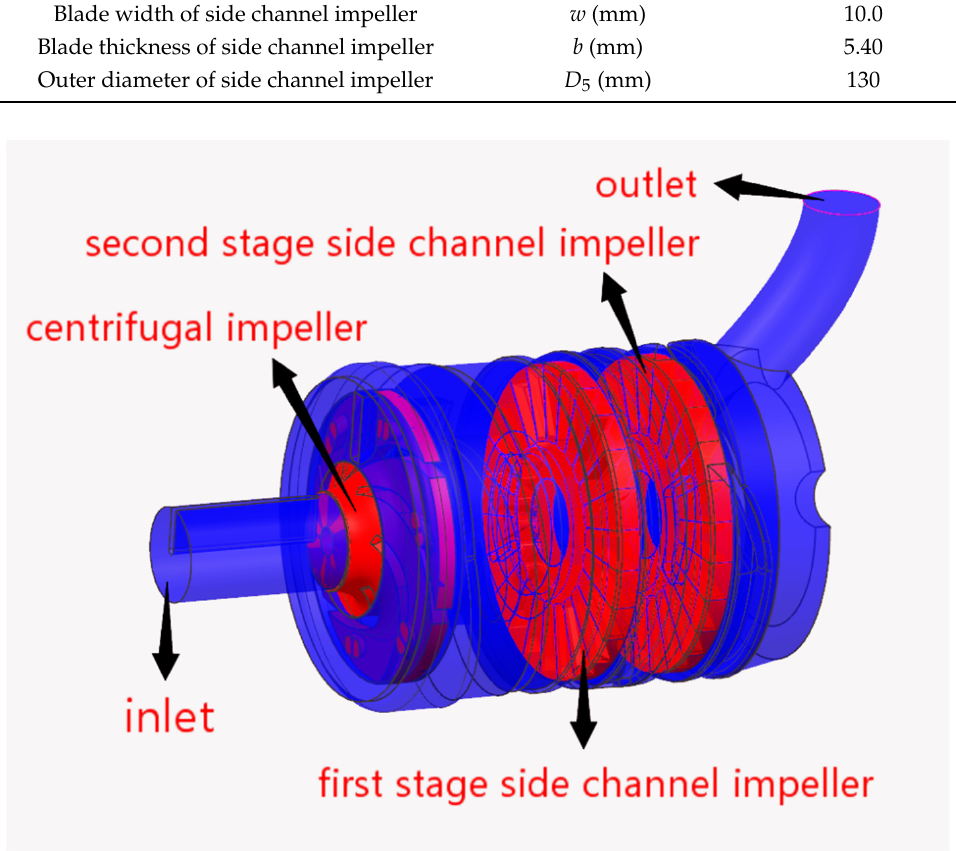
Figure 1. Water structure diagram of the investigated multistage side channel pump.